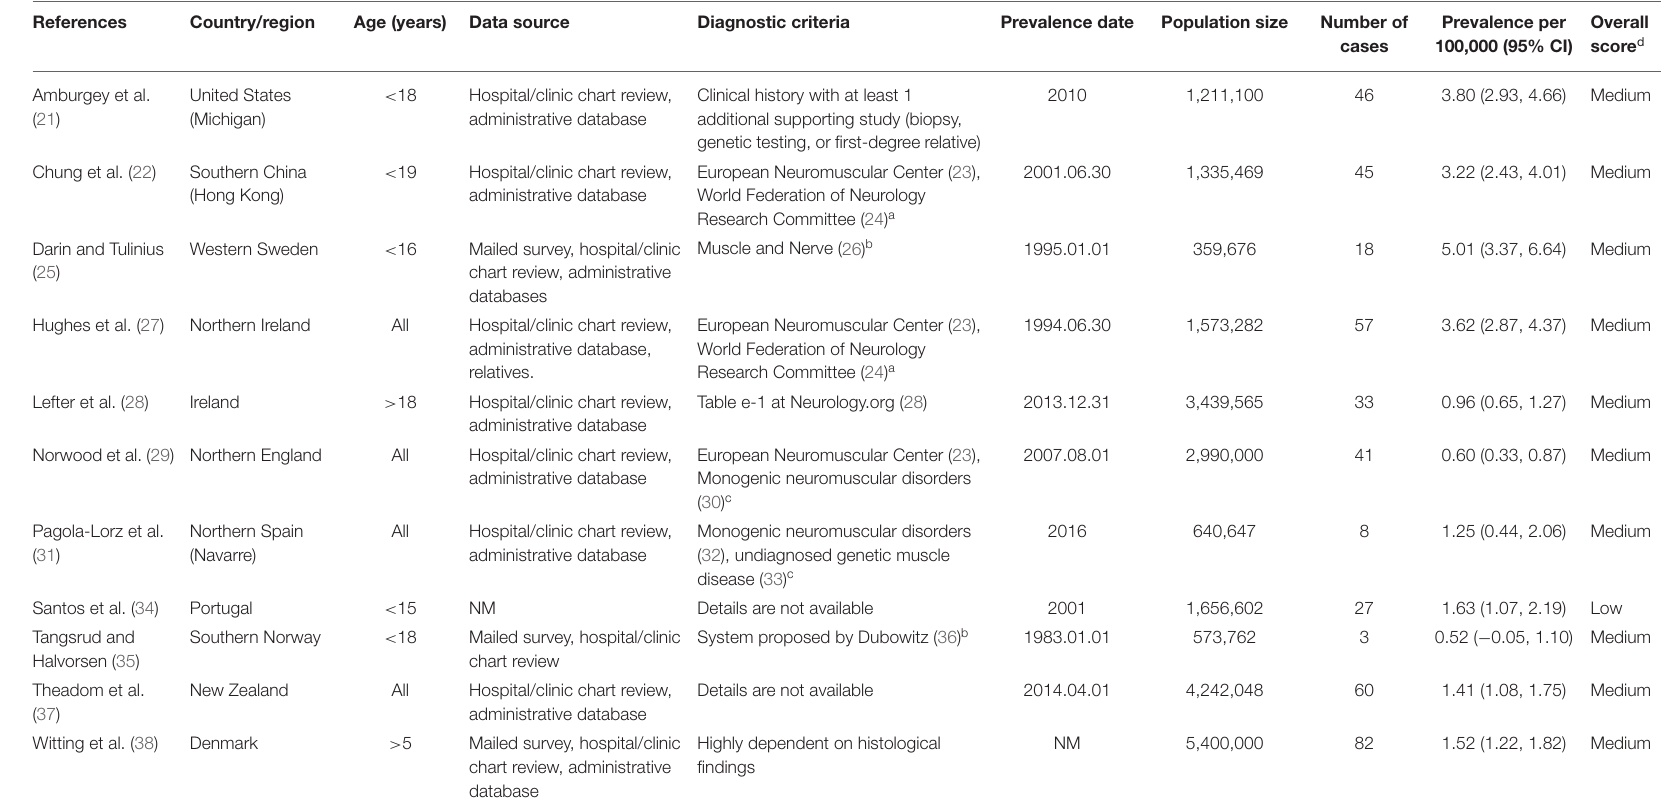
TABLE 1 | Characteristics of the included studies on congenital myopathy